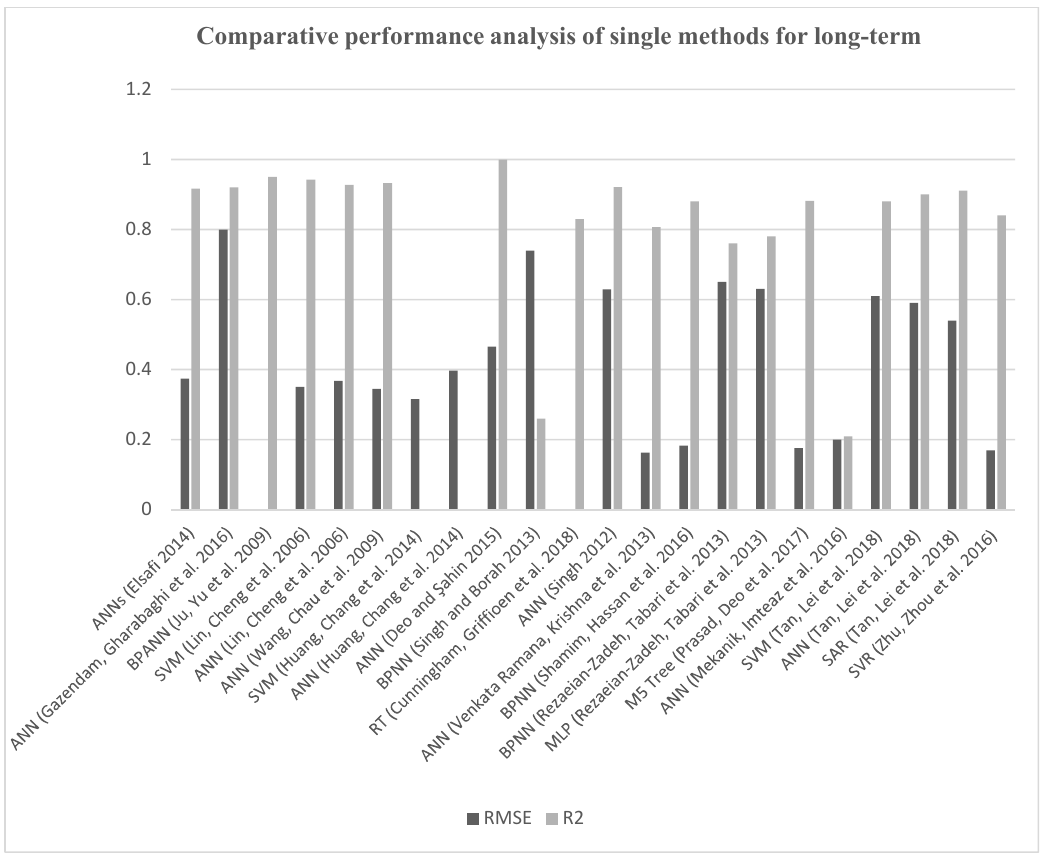
Figure 9. Comparative performance analysis of single methods of ML for long‐term prediction.